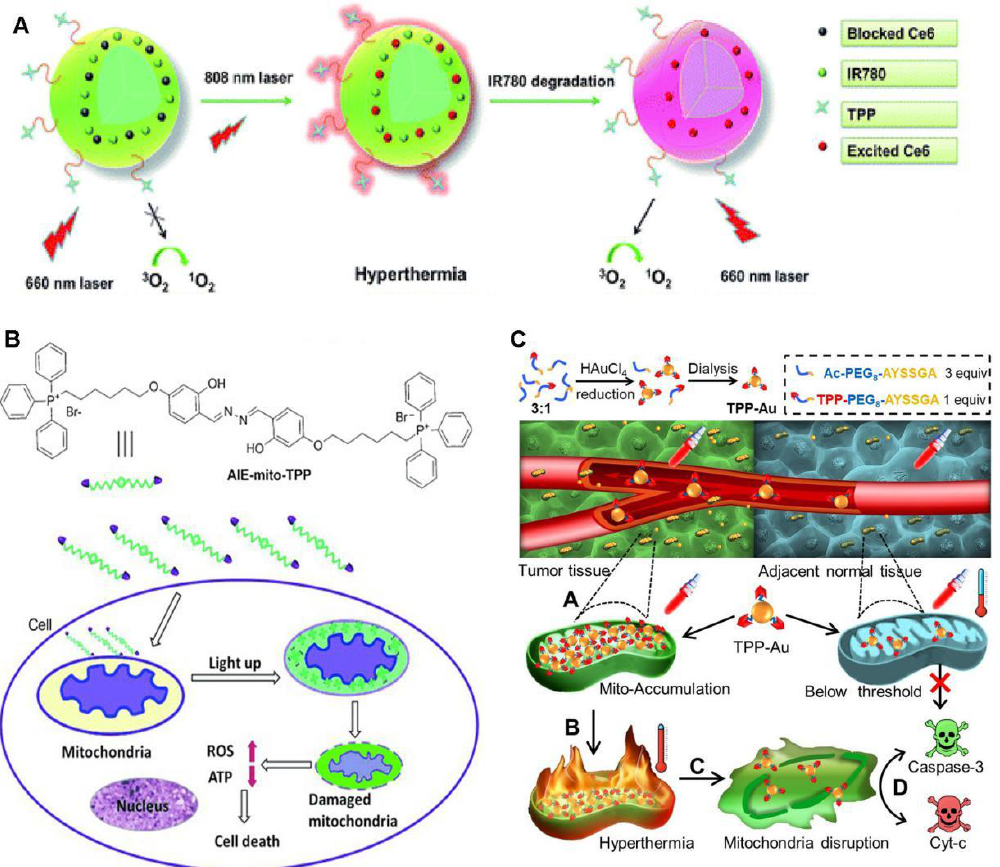
Figure 1. Triphenylphosphonium (TPP)-based mitochondria-targeted phototherapy (PT). ( A